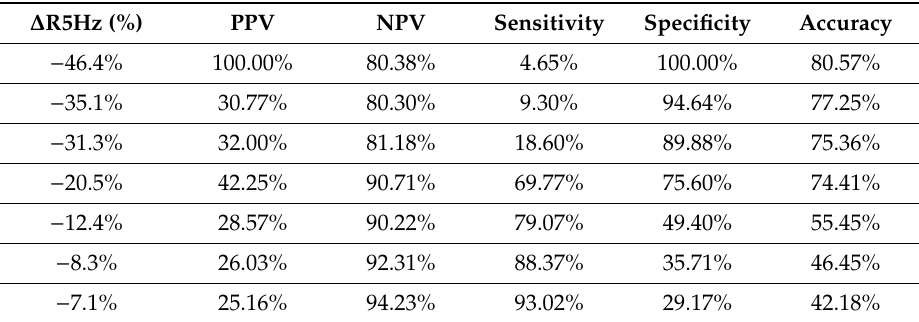
Table 3. Positive and negative predicted values, sensitivity and specificity between selected ∆ R5Hz values, and their ability to correctly classify wheezing episodes (or increase in peripheral resistance as it is assessed during a wheezing episode). ∆ R5Hz